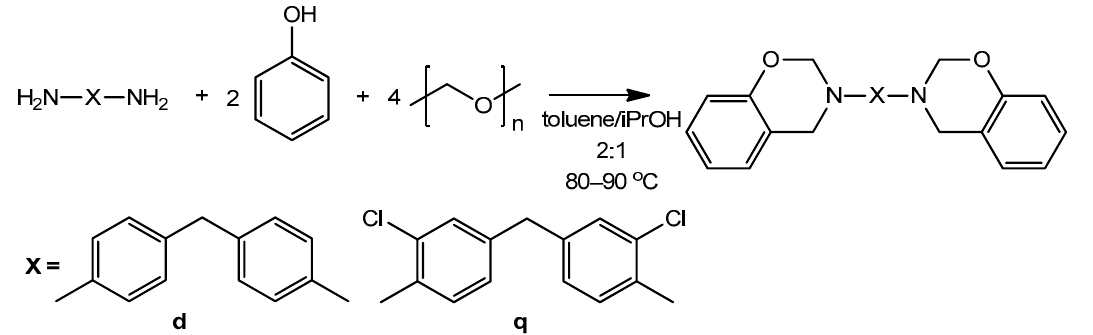
Figure 2. Synthesis of benzoxazine monomers based on diamines.